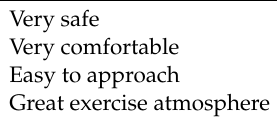
Table A3. Measurement of sport socialization situations.